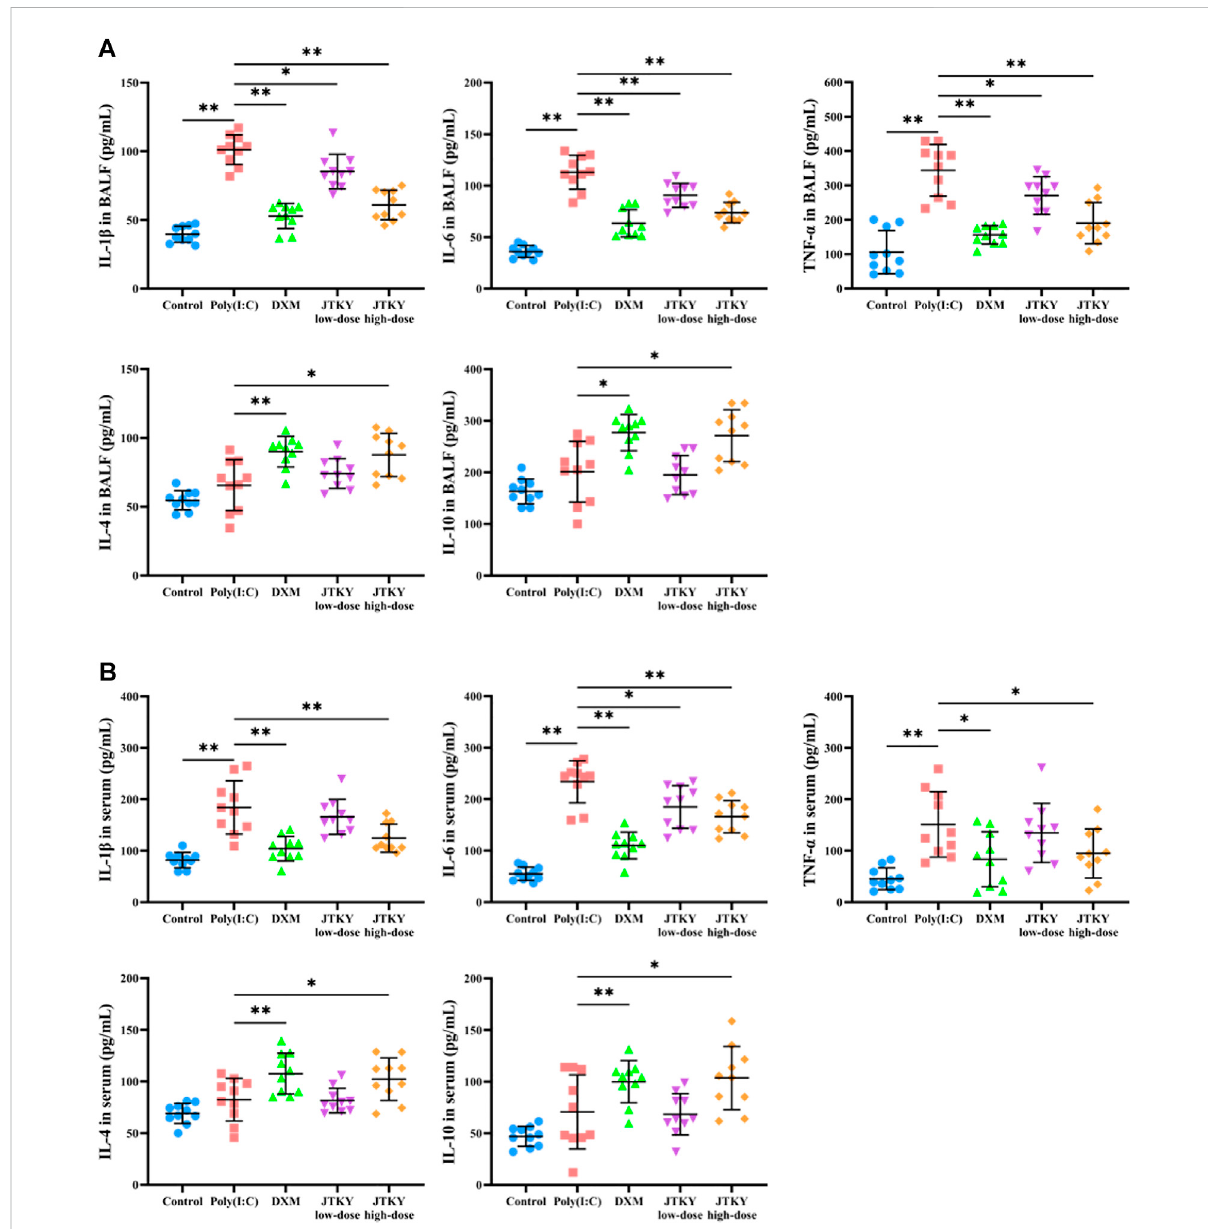
FIGURE 2 JTKY affected thelevels of cytokines in poly(I:C)-induced viral pneumonia model mice. (A,B) JTKY treatment decreased the levels of IL-1 β , IL-6 and TNF- α and increased the levels of IL-4 and IL-10 in BALF (A) and serum (B) . Control, poly(I:C), DXM, JTKY low-dose and JTKY high-dose groups ( n = 10 per group). *: p < 0.05; **: p <